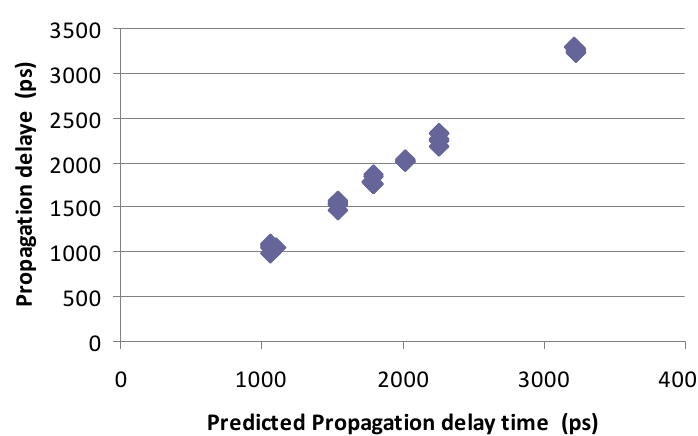
Figure 7. Results showing the correlation between in-circuit auto-calibration using on-board calibration standards switched in via microwave solid-state switch as compared to a traditional vector network analyzer calibration via traditional one-port S11 error correction method; testing utilized 4 replicated measures at 6 levels of